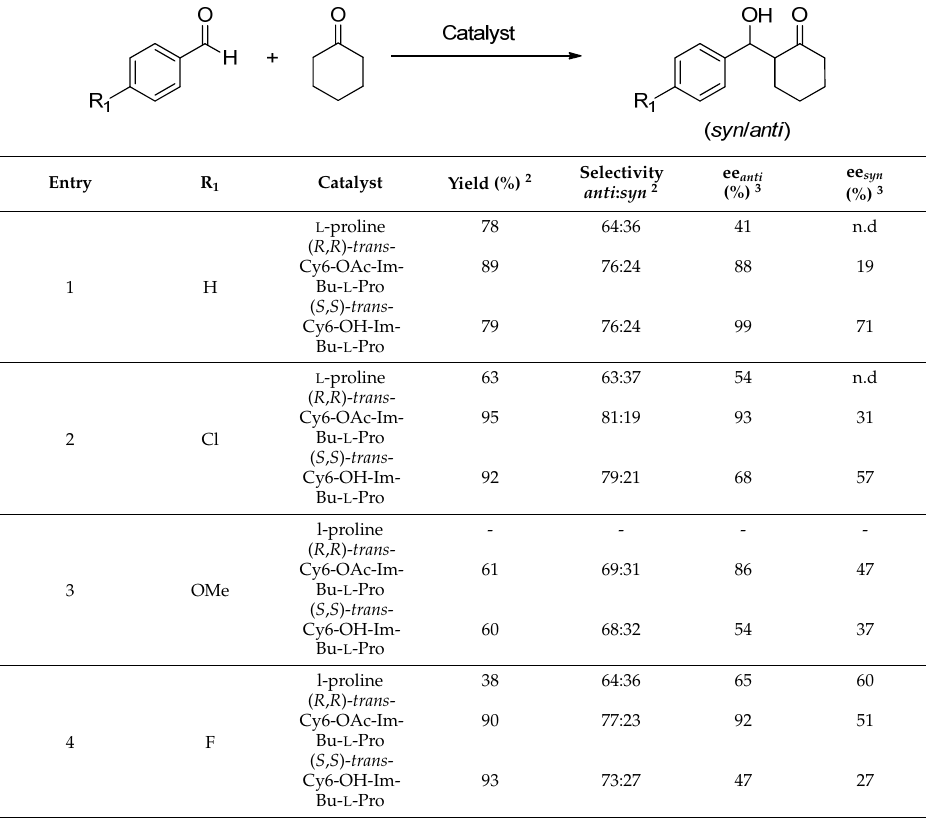
Table 5. Results of the aldol reaction between different aldehydes and cyclohexanone at room temperature for 24 h 1 .